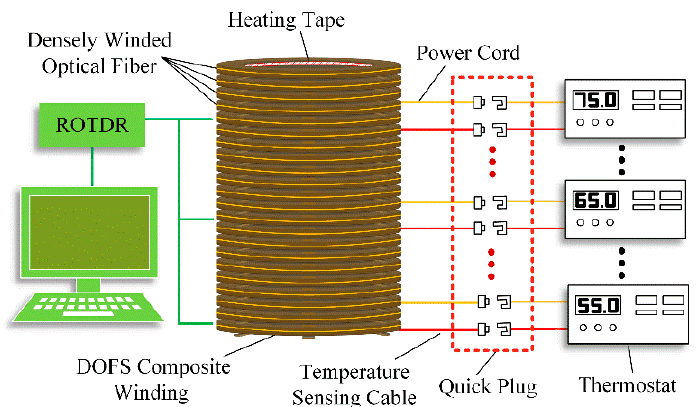
Figure 4. Schematic graph of the test platform.